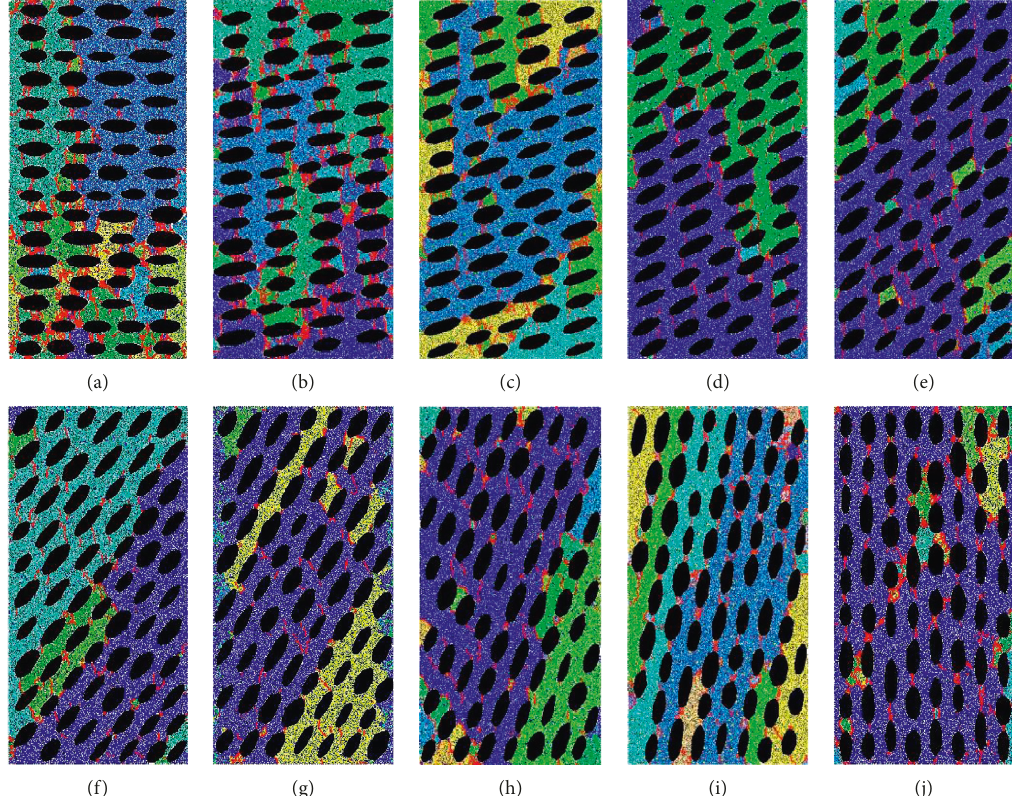
Figure 11: Distribution of the bond failure zone under different rock block inclinations. (a) 0 ° . (b) 10 ° . (c) 20 ° . (d) 30 ° . (e) 40 ° . (f) 50 ° . (g) 60 ° . (h) 70 ° . (i) 80 ° . (j) 90 ° .